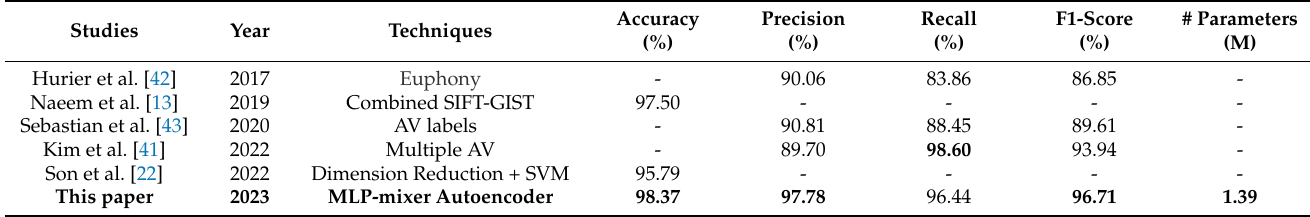
Table 7. Comparison with the latest malware classification models on the Malheur